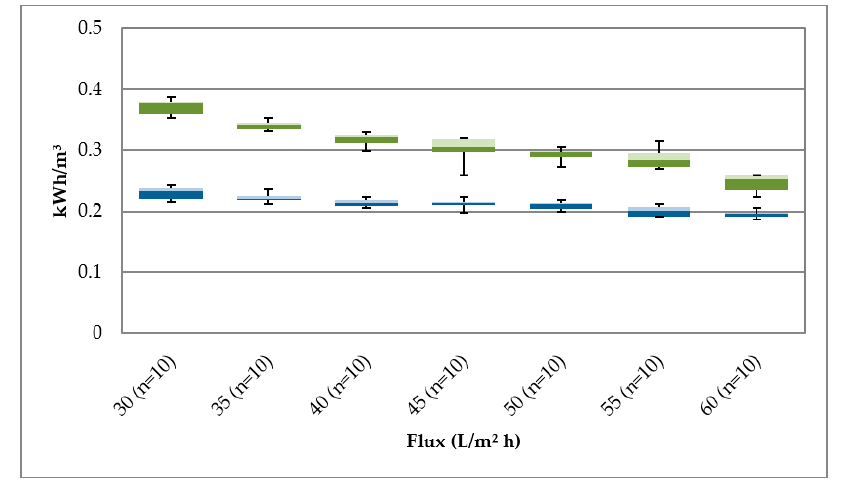
Figure 6. The energy consumption per m 3 filtrate produced from Elbe River water (green) and bank filtrate (blue) with identical operation settings of the membrane plant (UF 1 and UF 2).